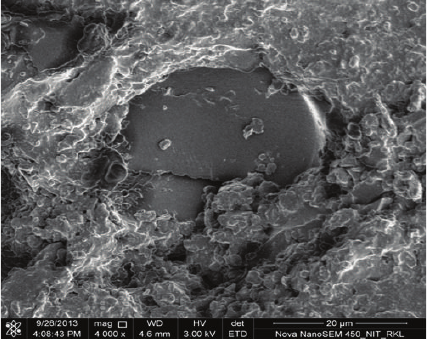
Figure 14: SEM of eroded composite surface (impact velocity 48 m/s, 20 wt% filler, and impact 45 ∘